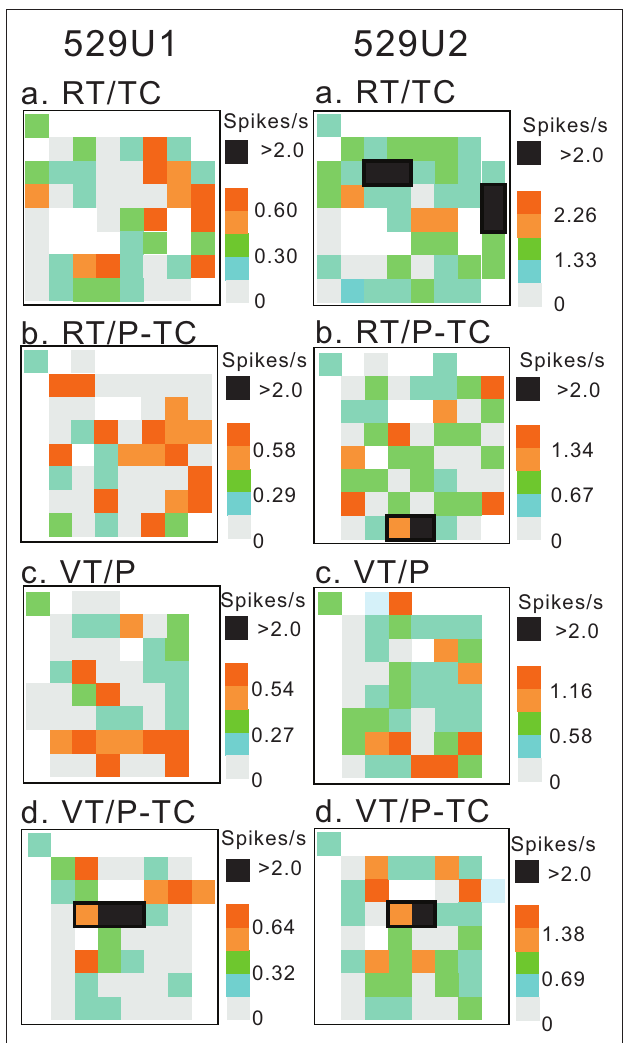
Figure 11 | Firing rate maps of a pair of neurons 529u1 and 529u2 which displayed a task-dependent CCr in the VT/P-TC task shown in Figure 4. Place fields are surrounded by thick lines. Within the place fields, pixels with the firing rates greater than 2.0 spikes/s are indicated by filled squares. Note that place fields of the both neurons overlapped in the VT/P-TC task. Calibration is shown in right; a mean firing rate for each pixel was expressed as a relative firing rate ( R ) in which the mean firing rate in each pixel was divided by the grand mean firing rate ( M ) in each task, and shown in five steps ( R ≥ 2 M ; 2.0 M > R ≥ 1.5 M ; 1.5 M > R ≥ 1.0 M ; 1.0 M > R ≥ 0.5 M ; R < 0.5 M ). Three values in the calibration indicate those of 2 M , M , and 0, respectively. Regions not visited by the monkey during the session(s) are shown by blank pixels.